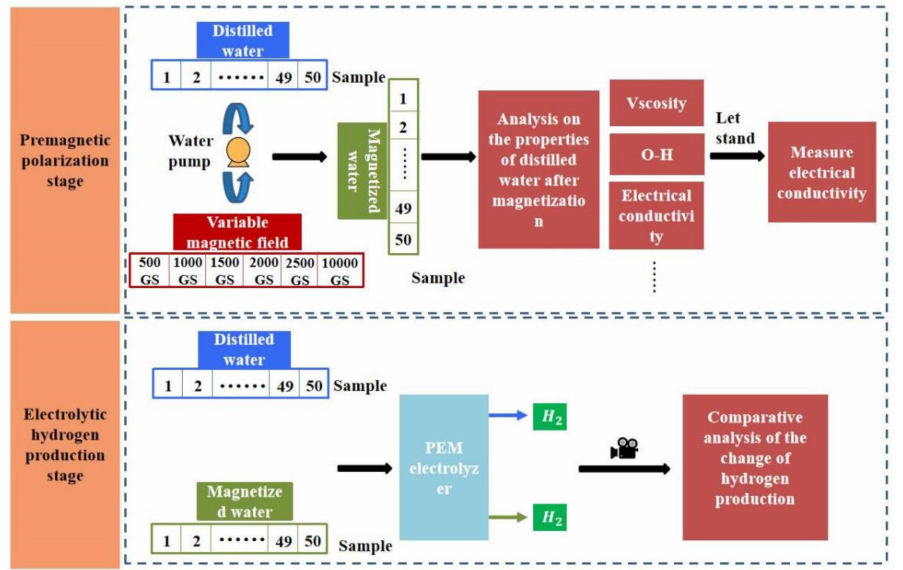
Figure 5. Experimental process diagram.